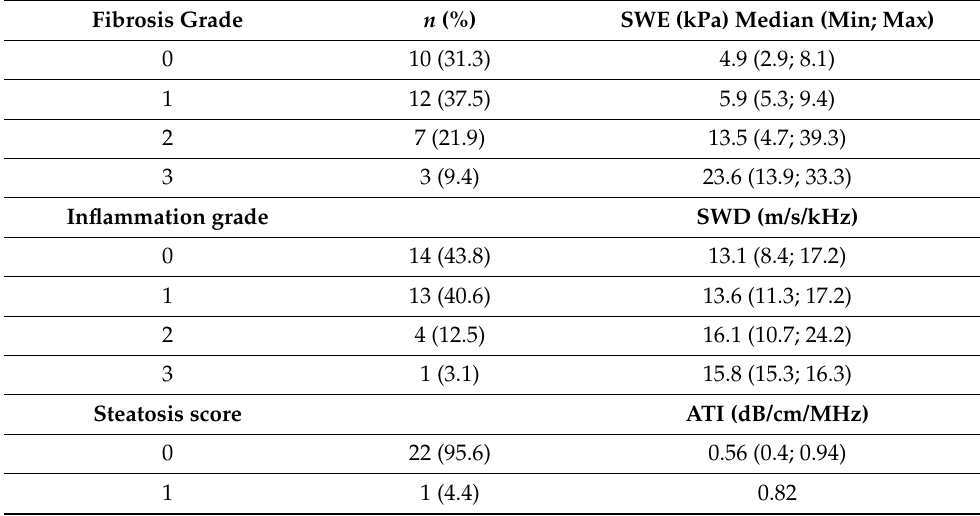
Table 3. Quantitative ultrasound markers stratified according to histological grading in patients.